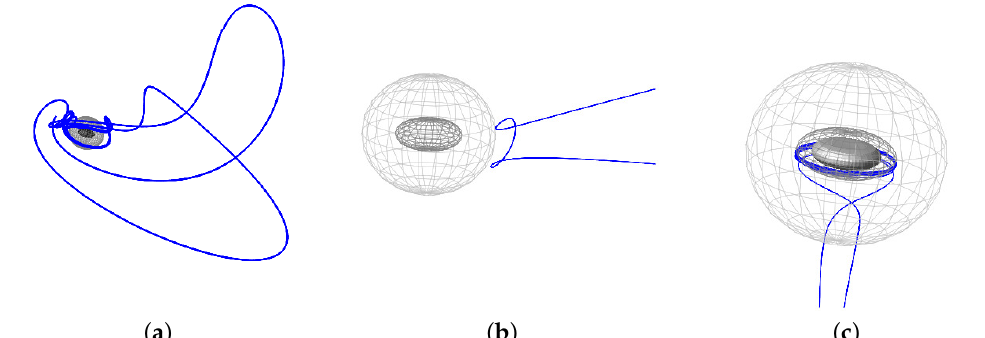
Figure 1. Orbits of particles (blue curves) around the rotating dyonic U ( 1 ) 2 black hole. The horizons are represented by grey ellipsoids and the dark grey structure is the singularity of the black hole. ( a ) Bound orbit; ( b ) Escape orbit; ( c ) Two-world escape orbit crossing both horizons twice and emerging into another